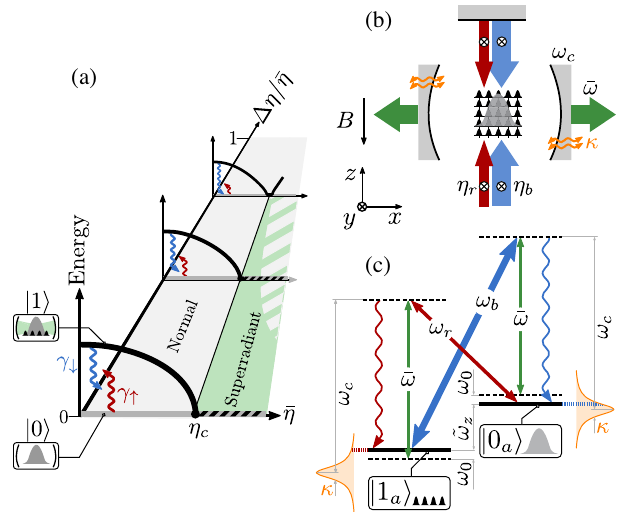
FIG. 1. Competing coherent coupling and dissipation at a superradiant phase transition. (a) A quantum gas interacts coherently with a cavity mode via two tunable drives with mean coupling strength ¯ η and imbalance Δ η , giving rise to two low- energy polariton modes j 0 i and j 1 i , corresponding to decoupled and coupled light-matter modes, respectively. Increasing ¯ η soft- ens the energy of j 1 i (black line); cavity dissipation is responsible for the effective damping ( γ ↓ ) and amplification ( γ ↑ ) of the soft- mode polariton j 1 i . For small enough Δ η = ¯ η , the rates γ ↓ and γ ↑ are balanced, and the mode softening to zero energy at ¯ η ¼ η is c accompanied by a phase transition from the normal phase populating only j 0 i (gray shade) to the superradiant phase (green shade), where j 1 i is occupied. By increasing Δ η = ¯ η , the domi- nating damping γ ↓ of the soft mode leads first to bistability (green-gray hashed region) and finally to the suppression of the superradiant transition. (b) Sketch of the experimental setup and (c) corresponding level scheme. A BEC inside a high-finesse cavity (with resonant frequency ω and field decay rate κ ) is c illuminated transversally by two Raman lasers with coupling strengths η and frequencies ω . The BEC ( j 0 ) couples to a b ð r Þ b ð r Þ a i spatially modulated state j 1 of the neighboring Zeeman sub- a i ℏ ð ω − 2 ω level, separated by an energy ℏ ˜ ω , with Zeeman z ¼ z rec Þ splitting ℏ ω and recoil energy ℏ ω . In the superradiant phase, a z rec coherent field at frequency ¯ ω (green) builds up in the cavity. The two-photon transitions driven by each pump and the cavity field at ¯ ω are detuned from the bare atomic states j 0 and j 1 by ∓ ω 0 , a i a i as indicated by the lower dashed lines. The dissipative channels between modes j 0 i and j 1 i shown in (a) are due to Raman scattering of photons from each single drive into the cavity (blue and red wiggly arrows) and subsequent photon loss. The Lor- entzian density of states of the cavity is sketched in